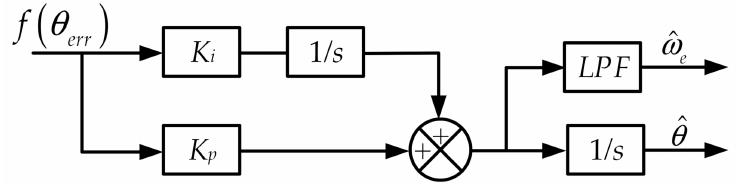
Figure 1. PI-type software phase-locked loop.